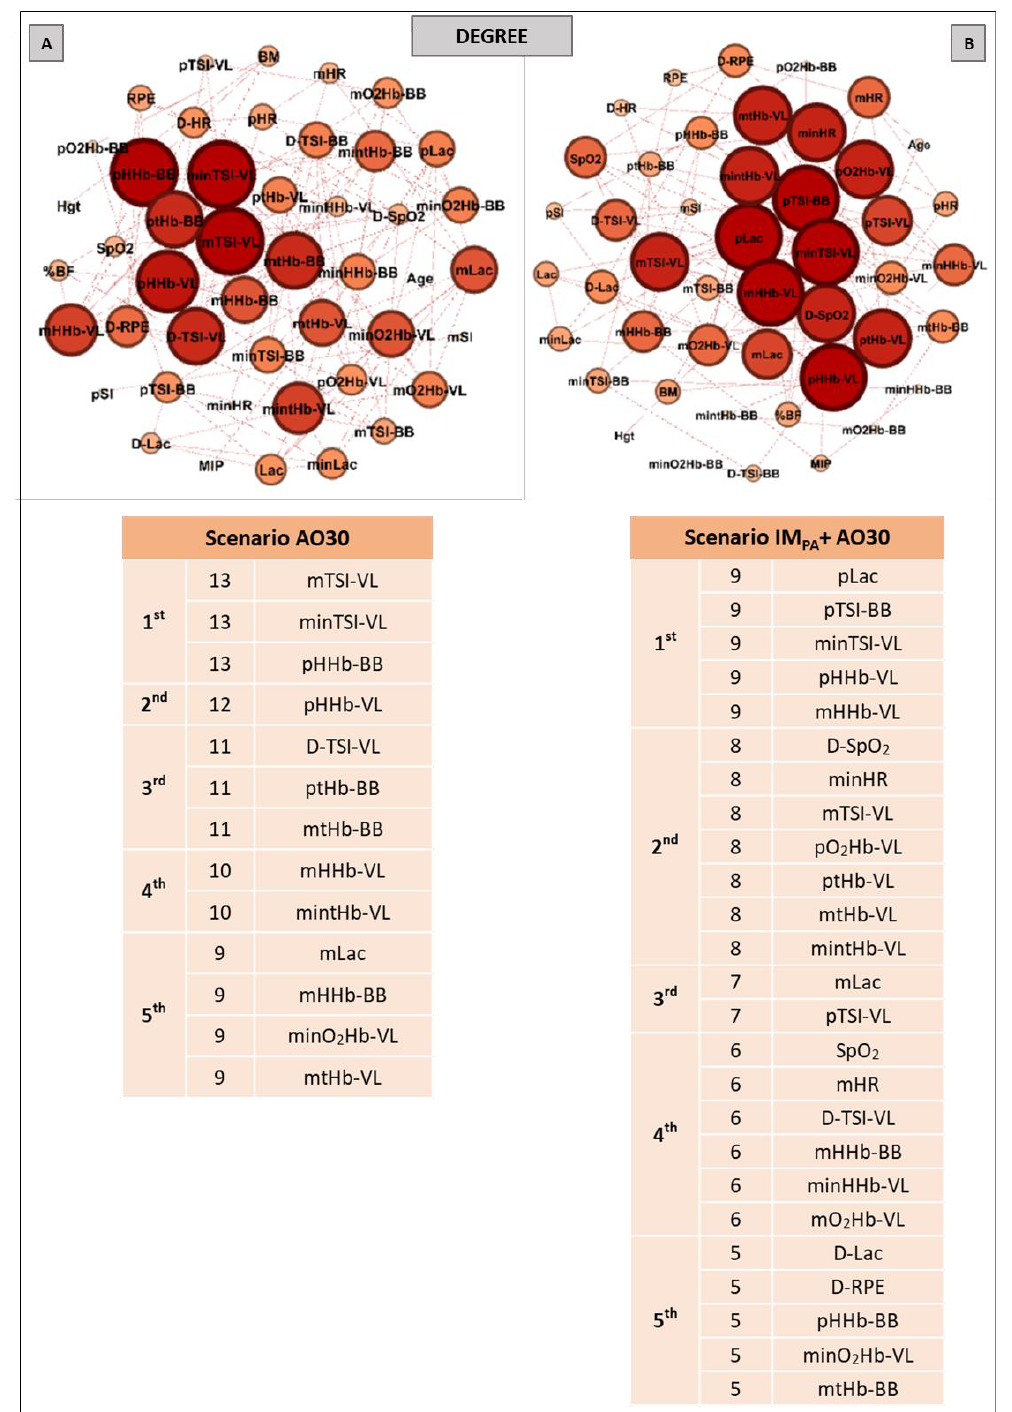
Figure 2. Graphs and top five node results obtained by complex network analysis using the Degree metric in two exercise scenarios: without inspiratory muscle pre-activation (Scenario AO30 shown in Panel A ) and with inspiratory muscle pre-activation (Scenario IM PA + AO30, Panel B ). Graph visualizations were done using Gephi software (version 0.9.2, Paris, France). Legend: AO30 = all-out 30 s, IM PA = inspiratory muscle pre-activation, Hgt = height, BM = body mass, %BF = percentage of body fat, MIP = maximal inspiratory pressure, SI = global strength index of inspiratory muscles, Lac = blood lactate, HR = heart rate, SpO 2 = arterial oxygen saturation, RPE = perceived exertion, O 2 Hb = oxyhemoglobin relative concentration, HHb = deoxyhemoglobin relative concentration, tHb = total hemoglobin, TSI = tissue saturation index. Abbreviations accompanied by p , m, min and D